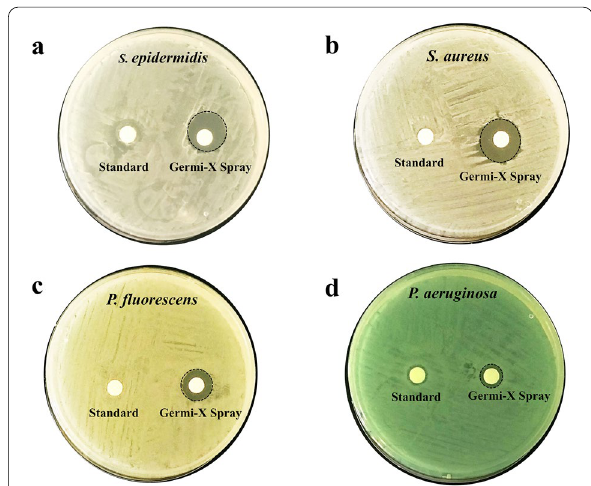
Fig. 1 Kirby Bauer disc diffusion assay showing anti-bacterial activity and prolonged surface retention of Germi-X spray. a – d Prolonged surface retention of Germi-X spray is depicted with representative digital images of S. epidermidis ( a ), S. aureus ( b ), P. fluorescens ( c ) and P. aeruginosa ( d ) showing the zones of inhibition (demarcated with black broken circles) around the discs soaked with Germi-X spray. Discs soaked in standard germicidal spray did not form any such bacterial growth free surrounding zones